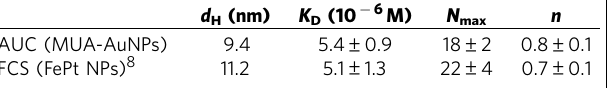
Table 2 | Interaction parameters for MUA–AuNPs with BSA by AUC and carboxylic acid coated FePt NPs with HSA by fluorescence correlation spectroscopy (FCS) 8